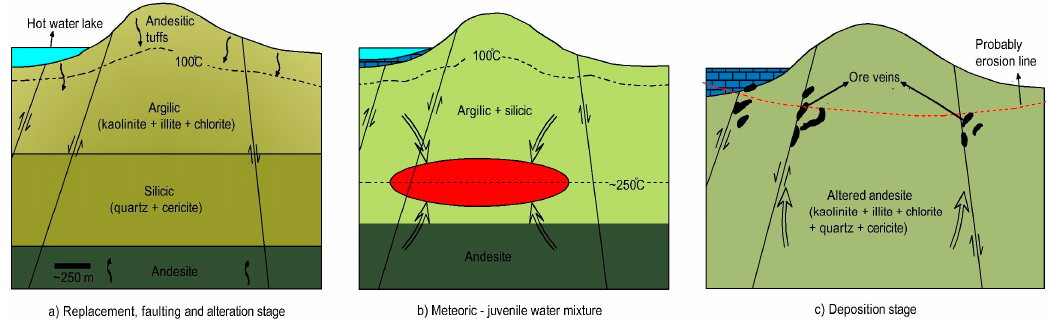
Figure 12. Ore genesis model for Tumanp ı nar ı .